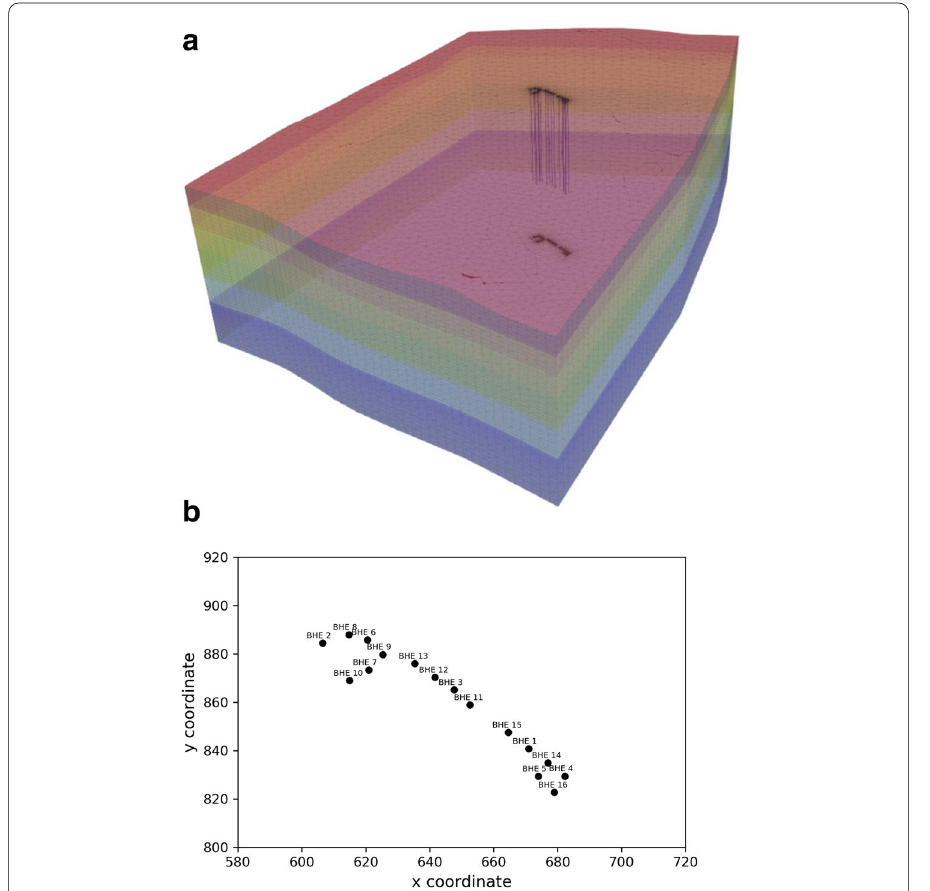
Fig. 2 a Domain and finite element mesh of the Berlin model, along with b the location and local coordinates of the BHEs